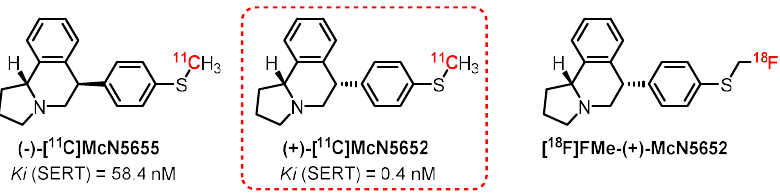
Figure 21. (−)-[ 11 C]McN5655 , (+)-[ 11 C]McN5652 , and [ 18 F]FMe-(+)-McN5652